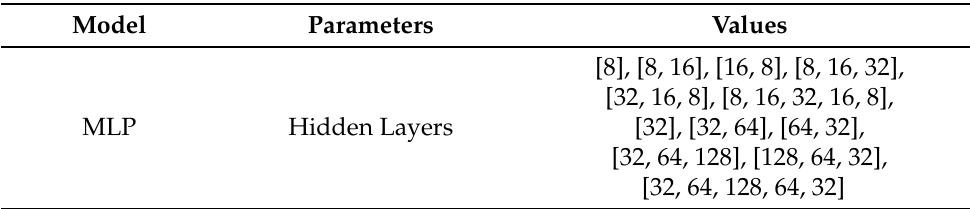
Table 5. Grid of parameters used for MLP